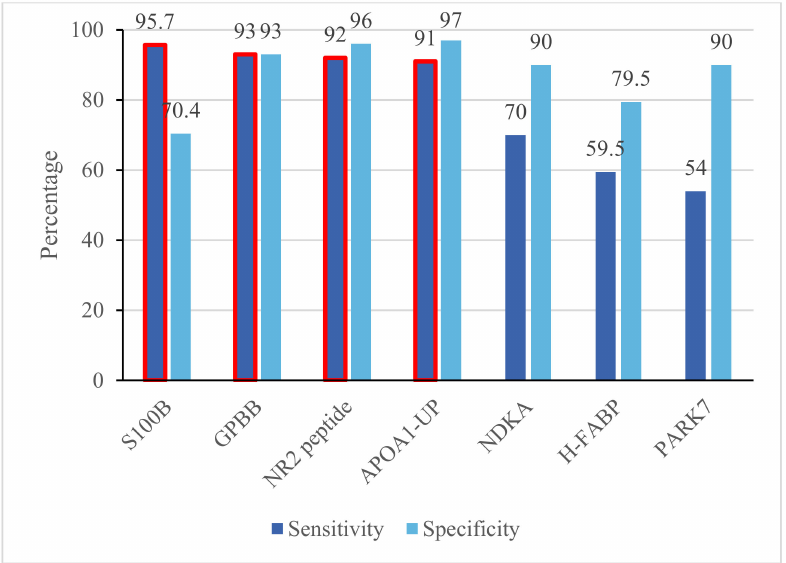
Figure 2. Single blood biomarkers for stroke. S100B, GPBB, NR2 peptide, and APOA1_UP all have sensitivities of >90% (highlighted in red). S100B, S100 calcium-binding protein B; GPBB, glycogen phosphorylase BB; NR2 peptide, a degradation product of N-methyl-d-aspartate receptors; APOA1- UP, apolipoprotein A1 unique peptide; NDKA, nucleoside diphosphate kinase A; H-FABP, heart-type fatty acid binding protein; PARK7, Parkinson disease protein